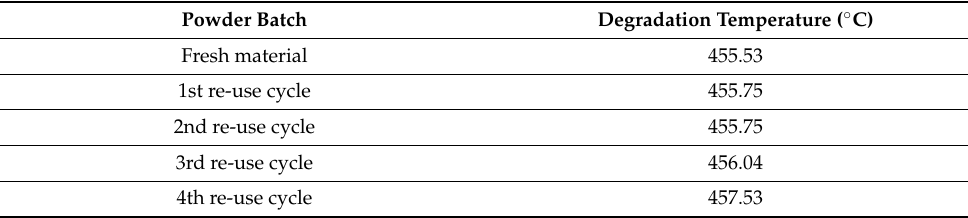
Table 8. TGA results for Laser PP CP 75 after 100%